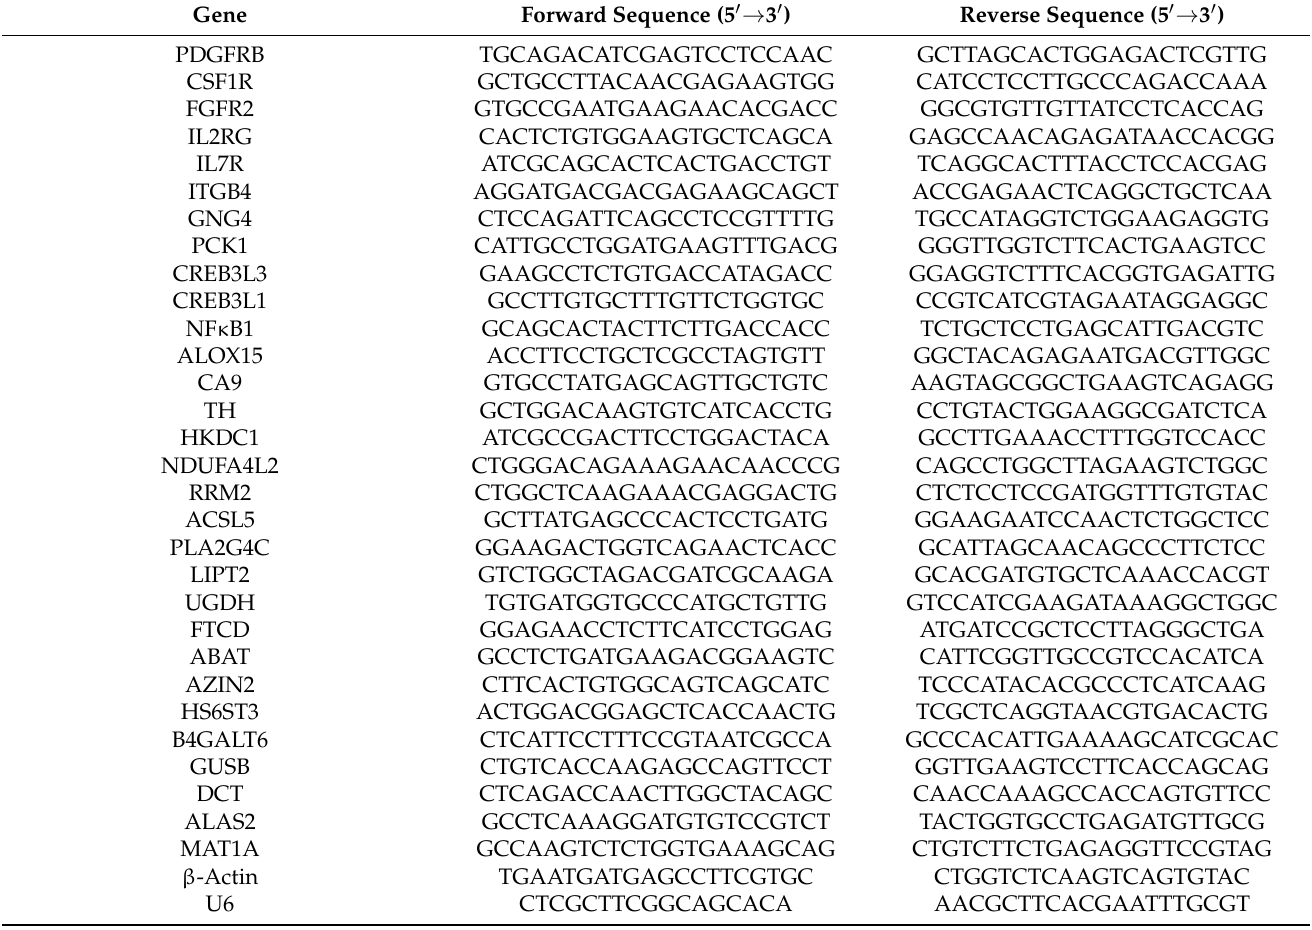
Table 3. List of 32 mRNA primers for real-time qPCR.